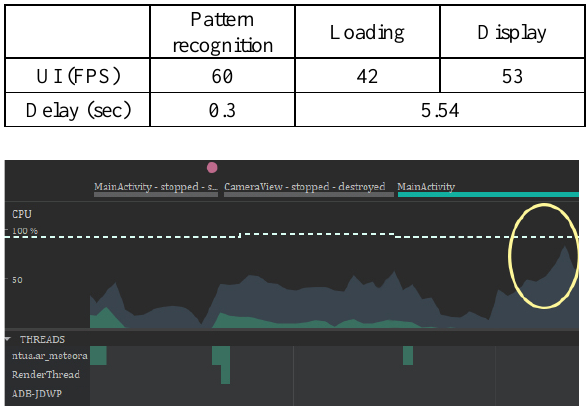
Table 1 . Metrics on UI thread, namely the main thread, at pattern recognition, loading and drawn time.